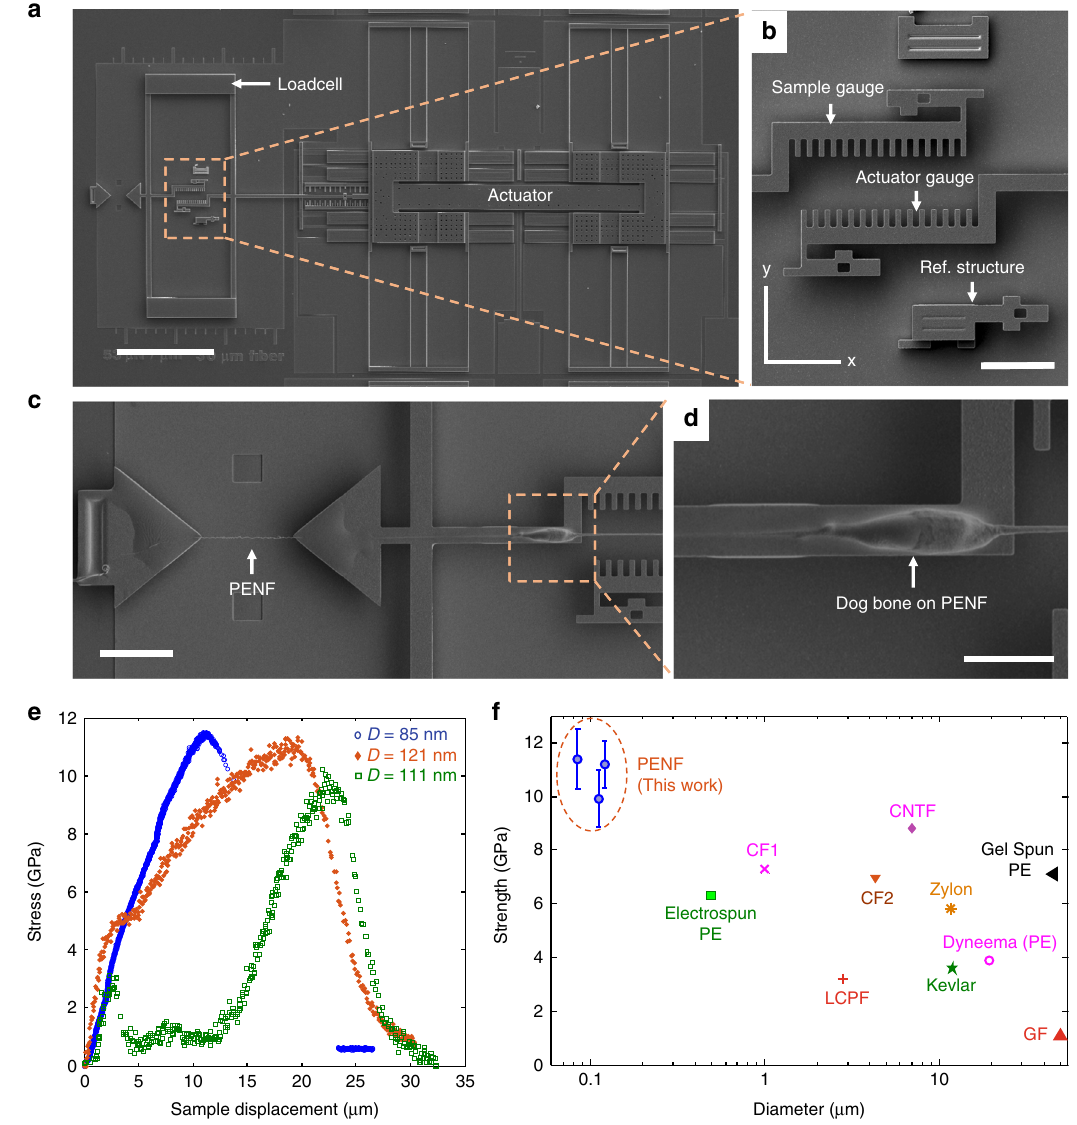
Fig. 5 Mechanical characterization of PENF. a-d SEM images of MEMS device used for tensile test of PENF. b Gauges for pattern matching to obtain sample displacement and loadcell extension. c A PENF gripped between two pads. d Dog bone shape on a PENF which provides additional grip due to mechanical locking. High contrast at the edges of dog bone is from charging of cured epoxy. e Stress-displacement curve. f σ ts of PENF compared to other fi bers such as electrospun PE 13 , CF1 14 (Carbon fi ber 1), CF2 (HexTow ® / Hexcel), CNTF 41 (Carbon nanotube fi ber), PE 42 (Gel-spun PE fi ber), Zylon ® / Toyobo, LCPF (Liquid crystal polymer fi ber, Vectran TM / Kuraray), Kevlar ® / Du Pont, Dyneema ® / Royal DSM, and GF 16 (Graphene fi ber). The error bars in PENF are calculated using uncertainty analysis (See Supplementary Note 5). Scale bars, 200 µ m ( a ), 25 µ m ( b, c ), and10 µ m ( d